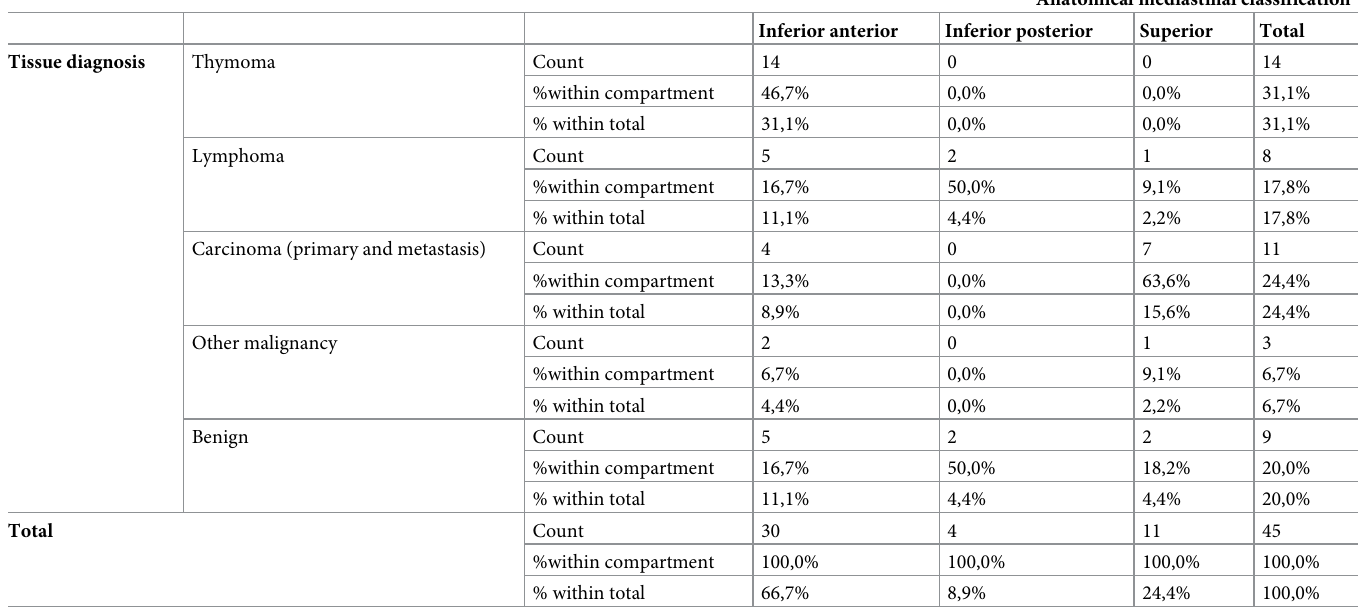
Anatomical mediastinal classification